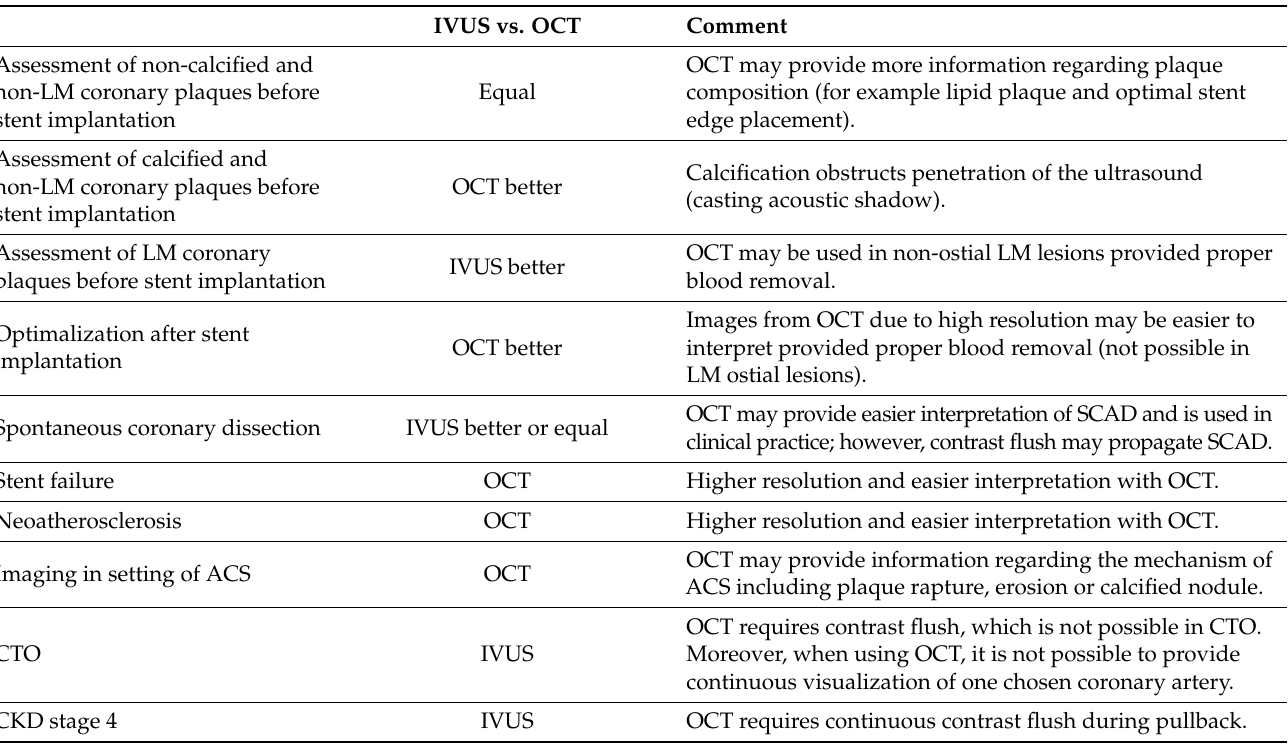
Table 2. Differences in IVUS and OCT in daily